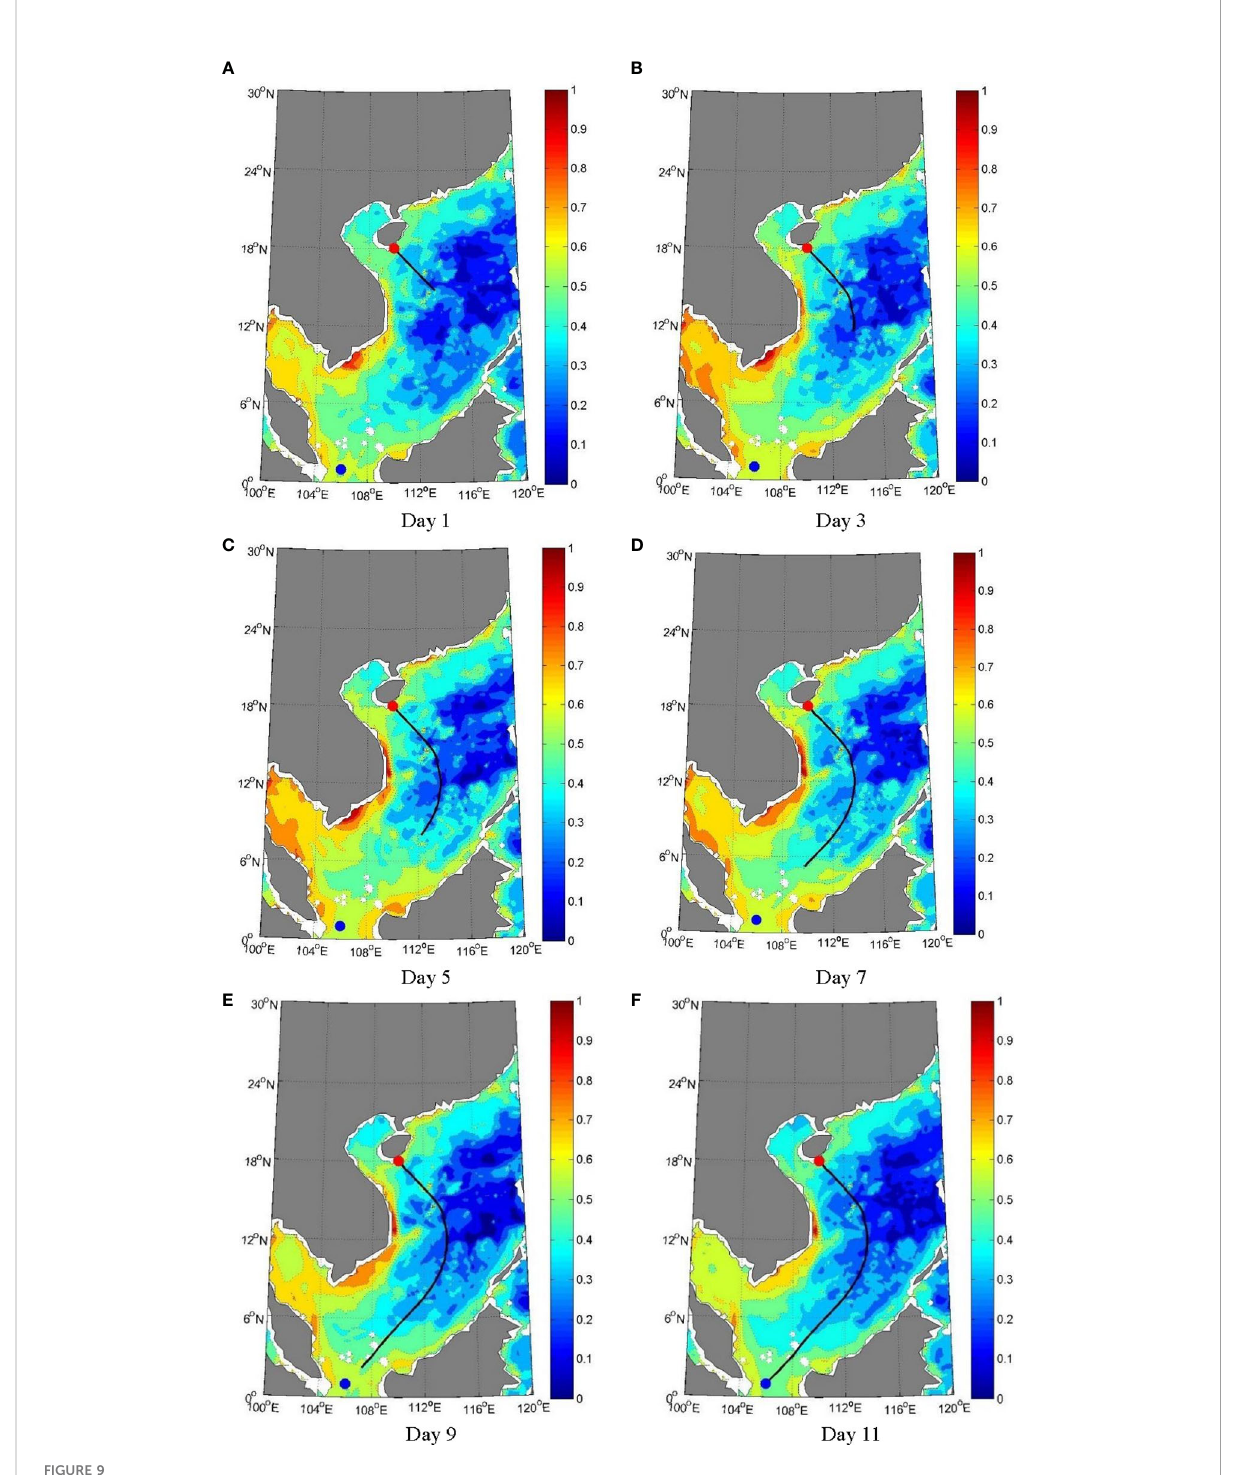
FIGURE 9 Real-time route planning results. [Day 1 (A) ; Day 3 (B) ; Day 5 (C) ; Day 7 (D) ; Day 9 (E) ; Day 11 (F)